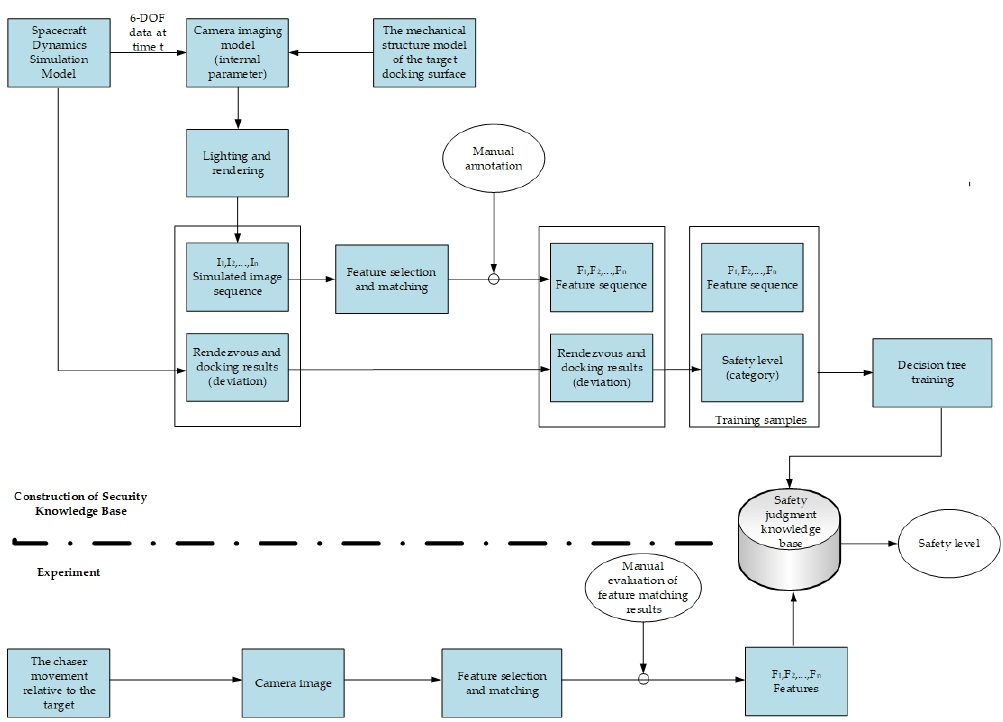
Figure 2. Self-judgment framework for safety of